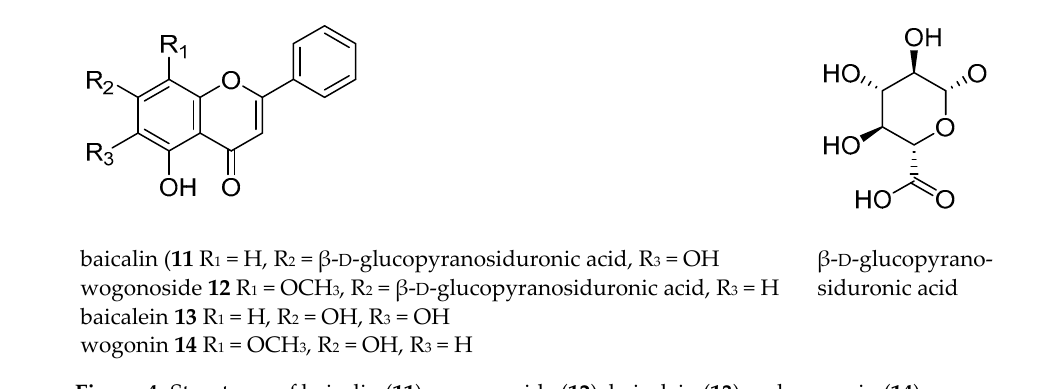
Figure 4. Structures of baicalin ( 11 ), wogonoside ( 12 ), baicalein ( 13 ) and wogonin ( 14 ). Table 1. Extraction efficiency of six model compounds by IPSE carried out in a microfluidic chip and in Eppendorf tube. Extraction Efficiency of IPSE Chip in % (SD, n = Compounds